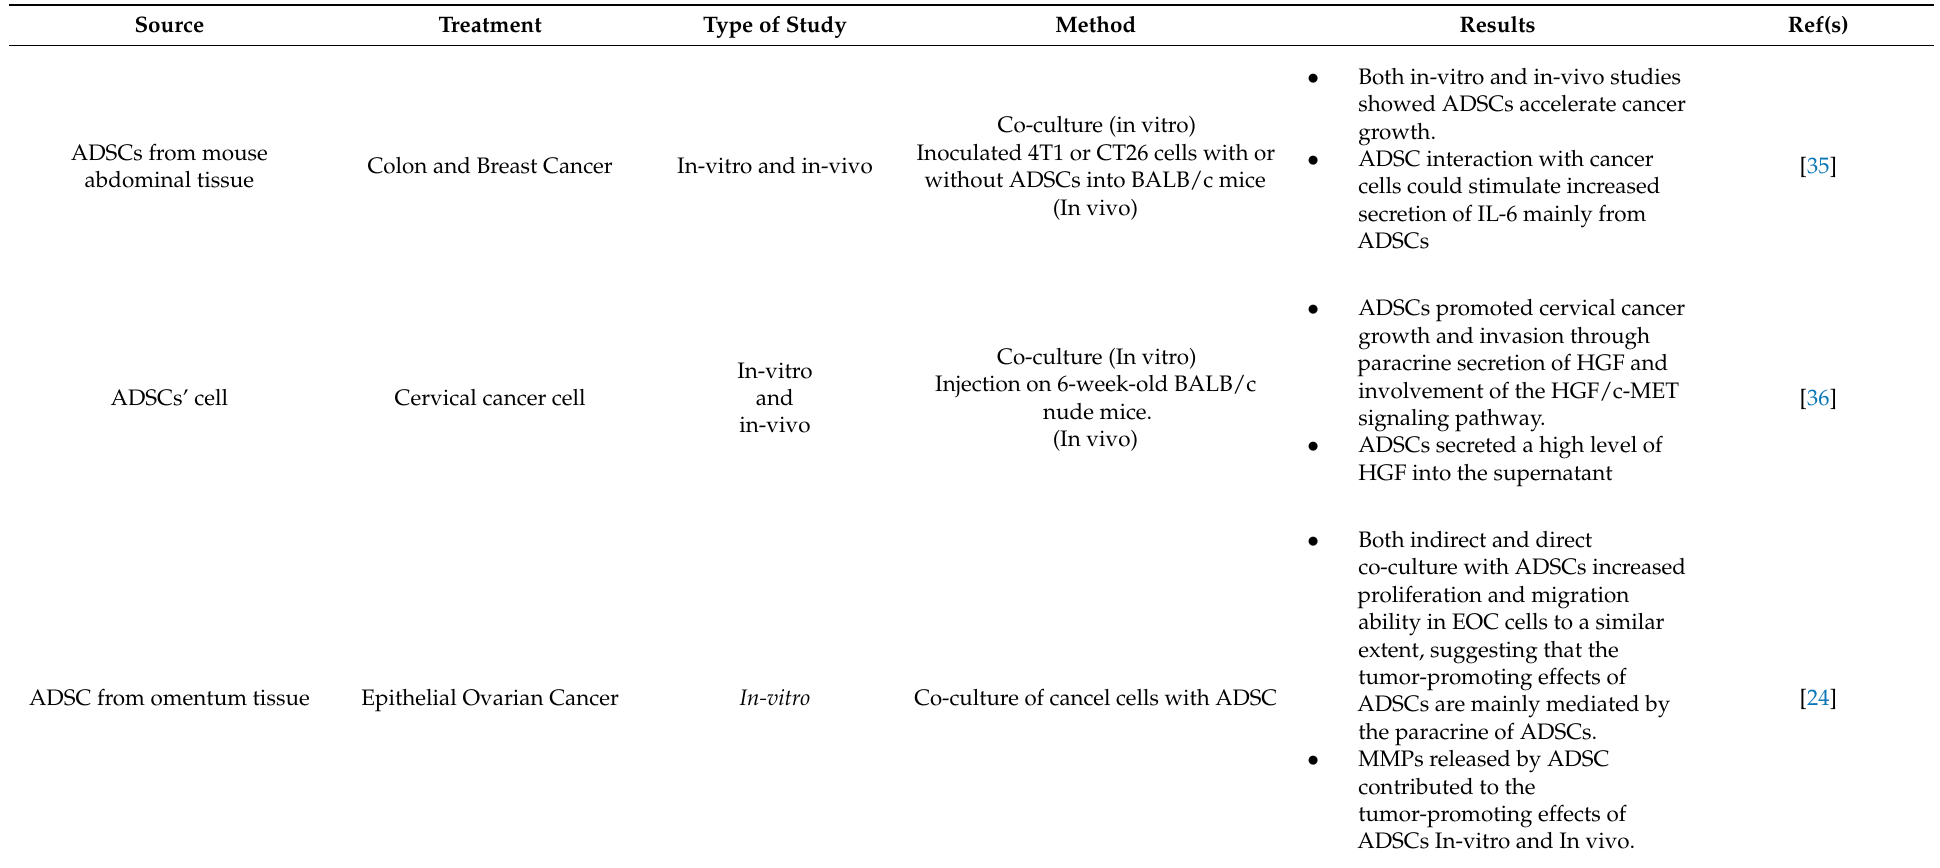
Table 2. The treatment using ADSCs and the negative side effect in In-vitro and In